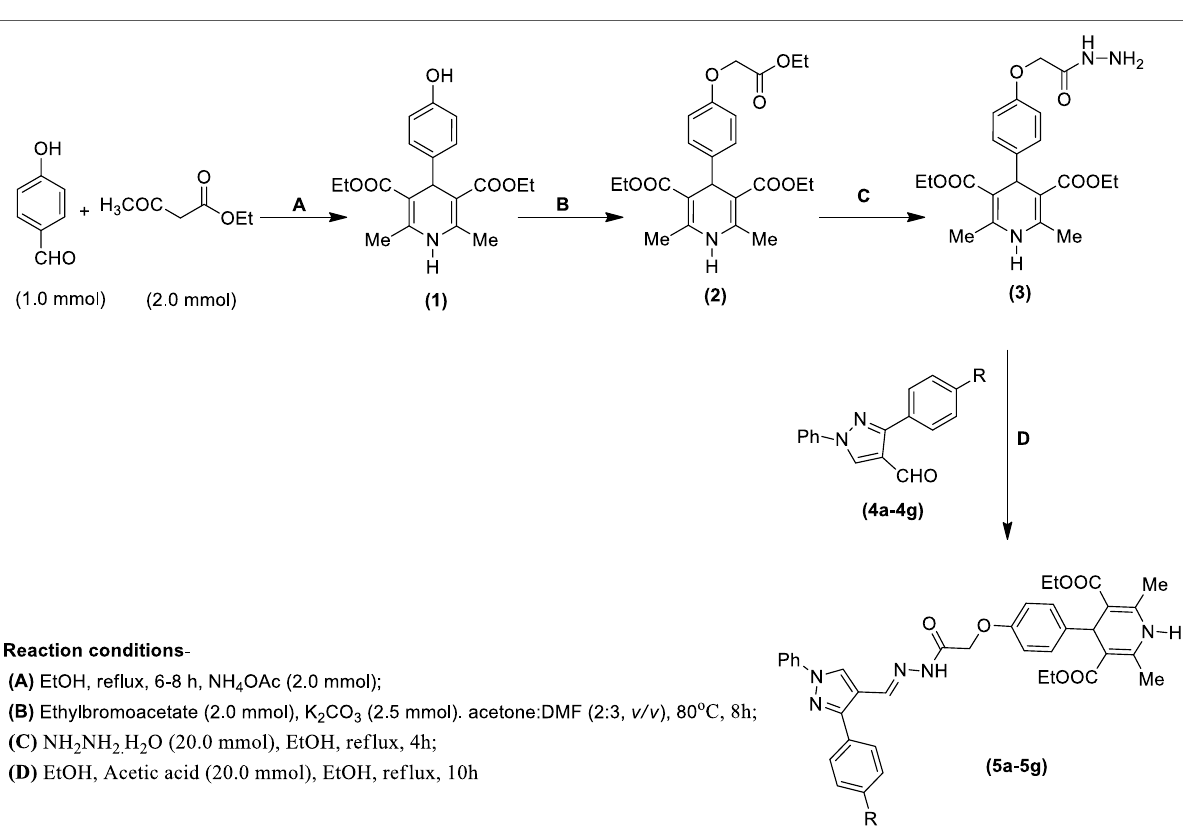
Table 1 Synthesis of diethyl 4-(4-(((3-aryl-1-phenyl- 1 H -pyrazol-4-yl)methyleneamino carbamoyl)methoxy)